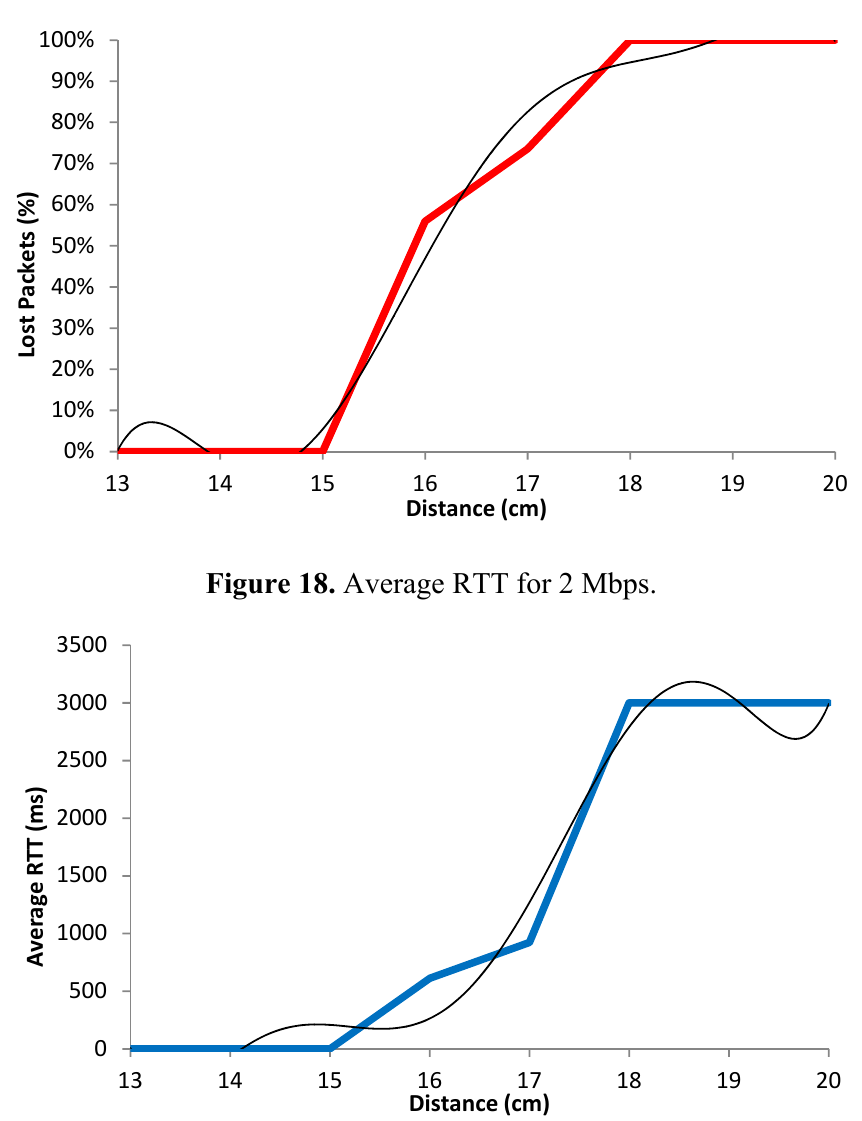
Figure 17. Average lost packets for 2 Mbps.